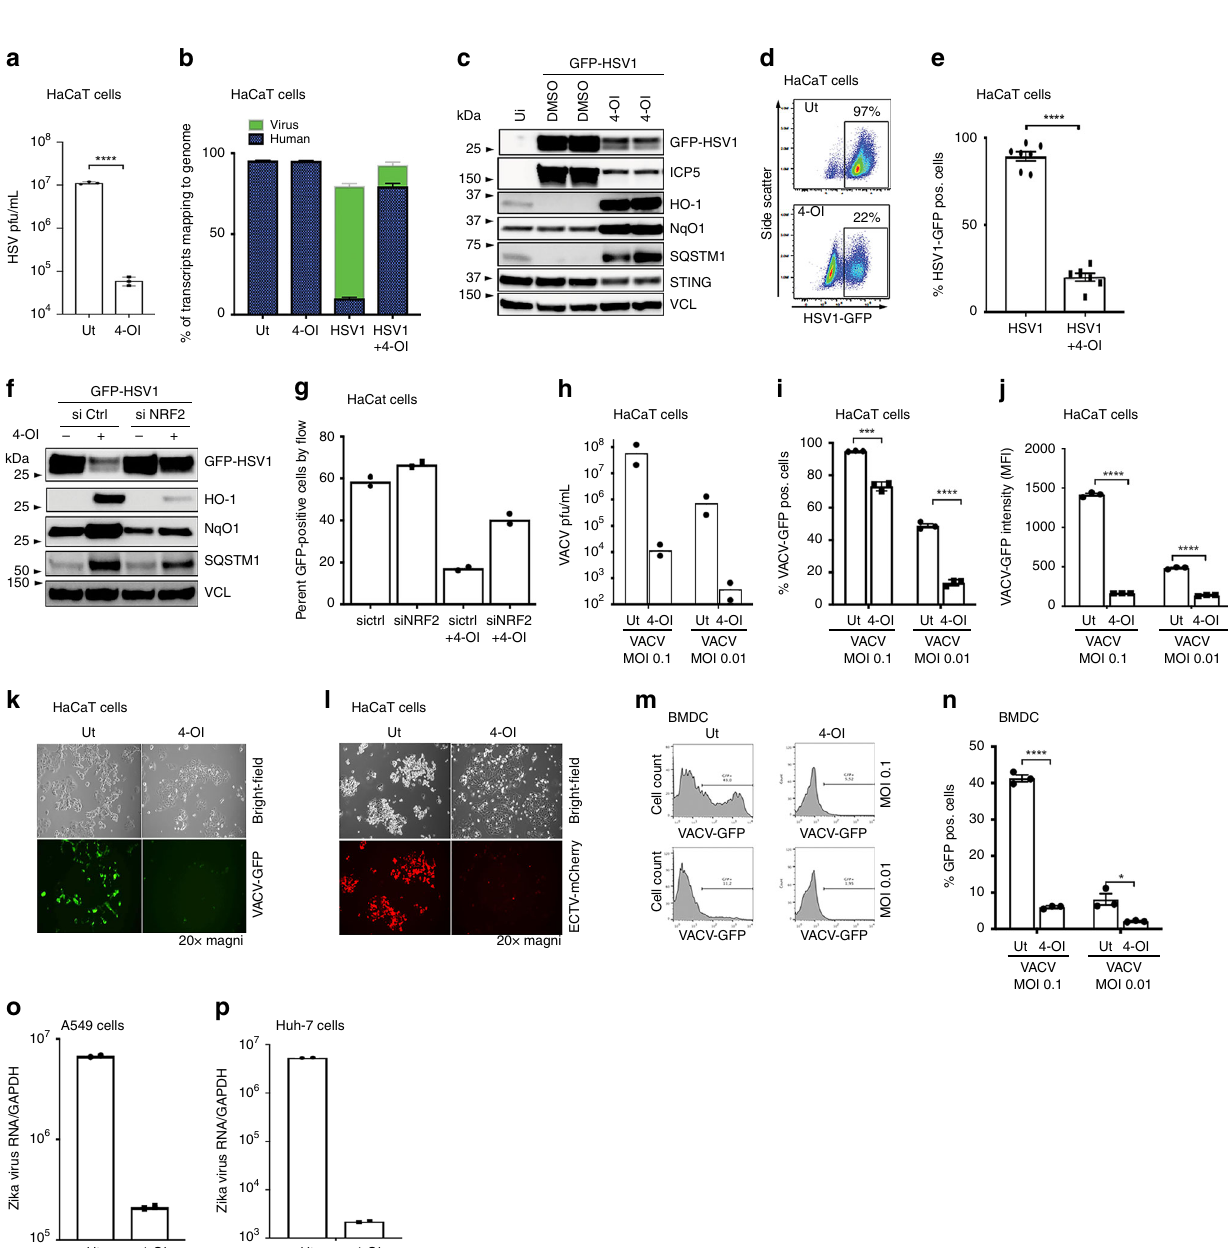
Fig. 3 4-OI broadly inhibits other pathogenic viruses including HSV, VACV, and Zika Virus. a HaCaT cells treated with 4-OI (125 μ M) for 48 h and infected with HSV1-GFP (MOI 0.01). Viral titers were determined by plaque assay. Data are obtained from one experiment of at least seven independent experiments each performed in triplicates. b RNA analyzed using RNA-sequencing ( n = 3) performed once. c – e HaCaT cells treated with 4-OI (125 μ M) and infected with HSV1-GFP (MOI 0.01). Lysates were analyzed by immunoblotting with Vinculin (VCL) as loading control and by fl ow cytometry ( n = 7 from three independent experiments). f , g HaCaT cells were lipofected with siRNA for 72 h, subsequently challenged with 4-OI (125 μ M) before HSV1-GFP infection (MOI 0.01) for 24 h. Infectivity and silencing ef fi ciency was determined by immunoblotting ( f ) and fl ow-cytometry ( g ). Data obtained from one experiment representative of three independent experiments. ( h – n ) HaCaT cells ( h - l ) and BMDCs ( m, n ) were treated with 4-OI (125 μ M) for 48 h and infected with VACV expressing either GFP or ECTV expressing mCherry for 24 h. Viral titers and infectivity were determined by plaque assay ( h ), fl ow cytometry ( i - j and m - n ), and visualized by confocal microscopy ( k - l ). Data in ( i , j ), and ( n ) are obtained from one experiment representative of two independent experiments each performed in triplicates. o - p A549 and Huh-7 cells were pre-treated with 4-OI for 48 h (150 μ M) and infected with Zika virus (ZIKV) (MOI 0.1) for 4 days. Viral genome was determined by qPCR. Data were obtained from one experiment representative of two independent experiments. For all panels, bars indicate mean ± s.e.m. Unless otherwise stated, all statistical analysis were performed using a two-tailed Mann – Whitney test to determine statistical signi fi cance where * p < 0.05, ** p < 0.01, *** p < 0.001, and **** p < 0.0001. Individual p values were, a : p < 0.0001, e: p < 0.0001, i: p = 0.0002(two tailed t test, MOI 0.1) and p < 0.0001(two tailed t test, MOI 0.01), j: p < 0.0001(two tailed t test, MOI 0.1) and p < 0.0001 (two tailed t test, MOI 0.01), n: p < 0.001(two tailed t test, MOI 0.1) and p = 0.0178(two tailed t test, MOI 0.01). Source data are provided as a Source Data fi